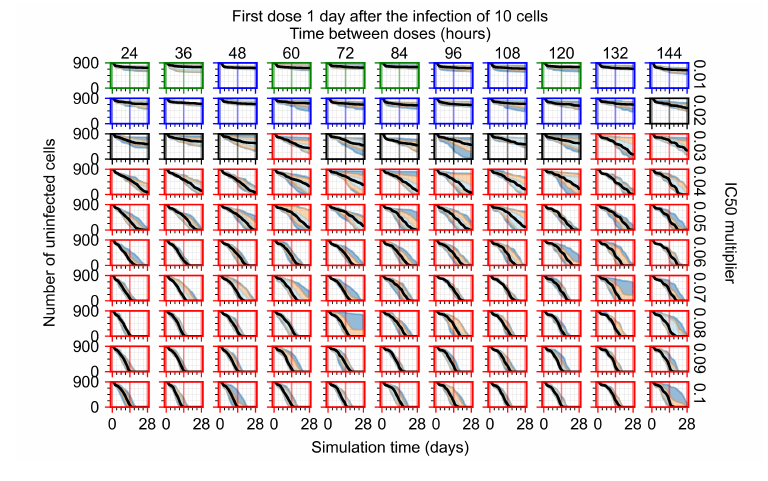
Figure A116. Uninfected population.